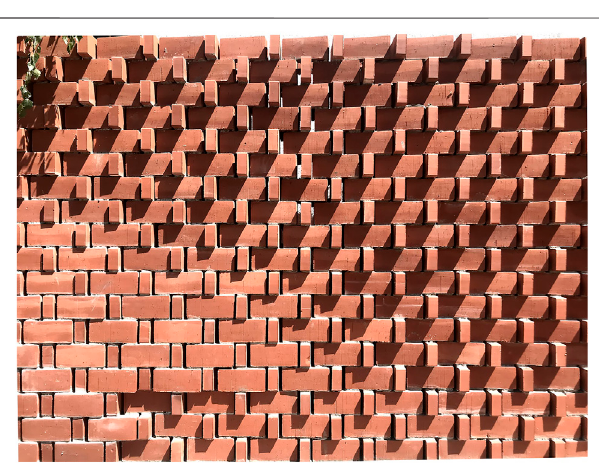
FIGURE 2 | Close-up of the self-shading effect of the robotically fabricated facade, shot on 7 August 2020, 13:02.